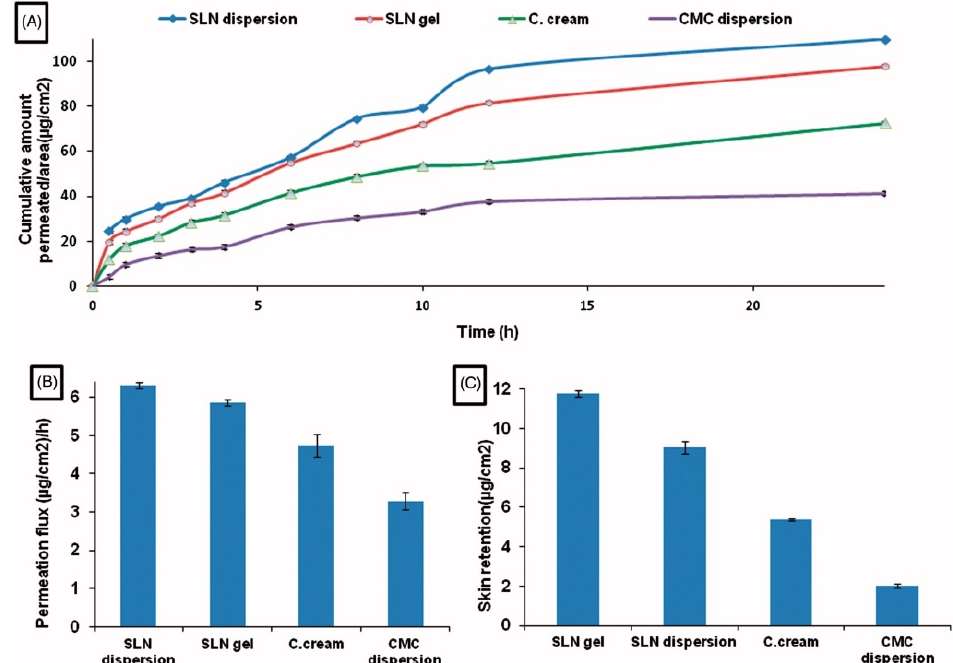
Figure 4. Time-dependent curve of cumulative amount permeated/area ( A ), permeation flux (µg/cm 2 /h) ( B ), and skin retention (µg/cm 2 ) ( C ) of different diflunisal-loaded medical substances. SLN dispersion—solid lipid nanoparticles dispersion; SLN gel—solid lipid nanoparticles gel; C. cream—conventional oil/water (o/w) cream; CMC dispersion—aqueous diflunisal dispersion in 0.5% solution of sodium carboxymethyl cellulose (CMC). Reproduced from [25], with permission from Taylor & Francis, 2021.